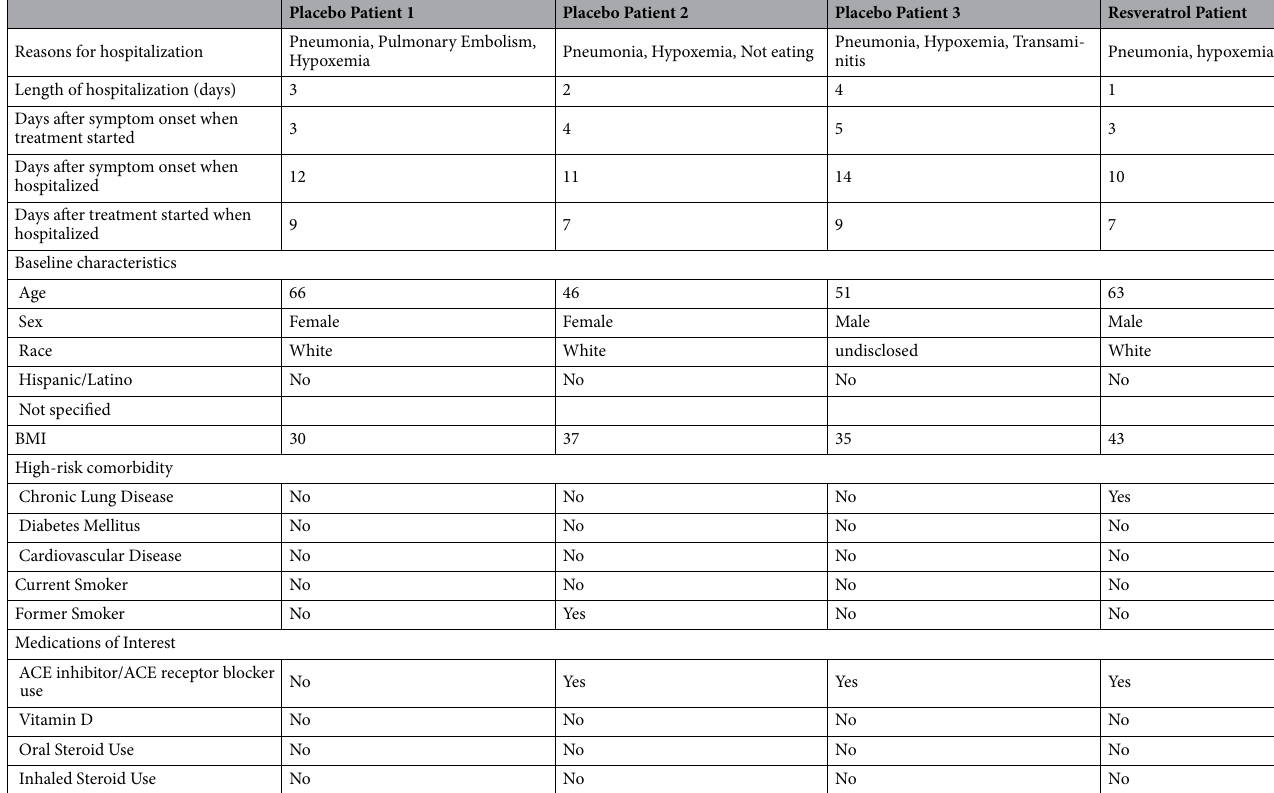
Table 2. Characteristics of individual hospitalized participants. This trial was conducted prior to the availability of COVID-19 vaccines.